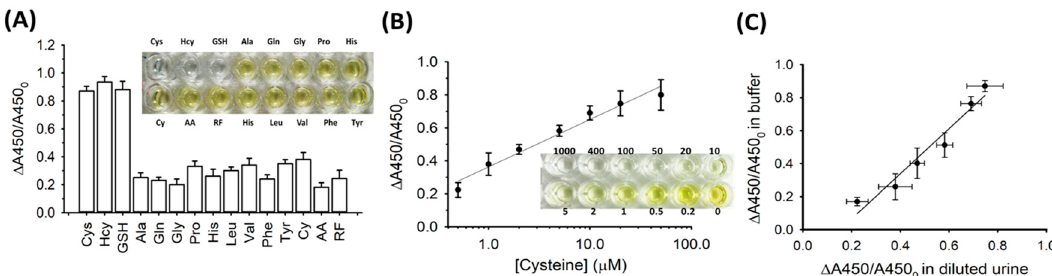
Figure 4. ( A ) Responses of our system toward 50 μ M biothiols molecules including cysteine (Cys), homocysteine (Hcy), and glutathione (GSH) and other amino acids. The inset shows the corresponding color. ( B ) A plot of the normalized absorbance values at 450 nm of the proposed system versus the concentration of cysteine in the urine sample. The inset shows the color responses of iodide-capped AuNPs to different concentrations of cysteine. ( C ) Correlation between the normalized absorbance results obtained in the diluted urine samples and the standard samples of cysteine with six concentrations (0.5, 1, 2, 5, 10, 20 μ M) ( R 2 = 0.95).